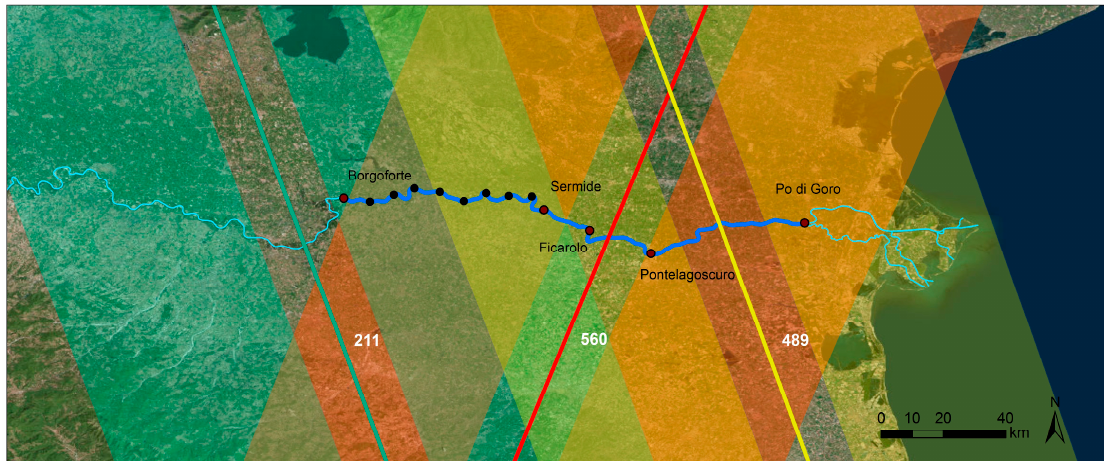
Figure 3. SWOT satellite coverage of the study area: satellite orbits and swaths (different colours) over the river portion of interest (dark blue); red dots represent the gauging stations considered in the study; and black dots present an example of swath discretization (560 upstream) adopting Δ x equal to 10 km (see Section 3.1).